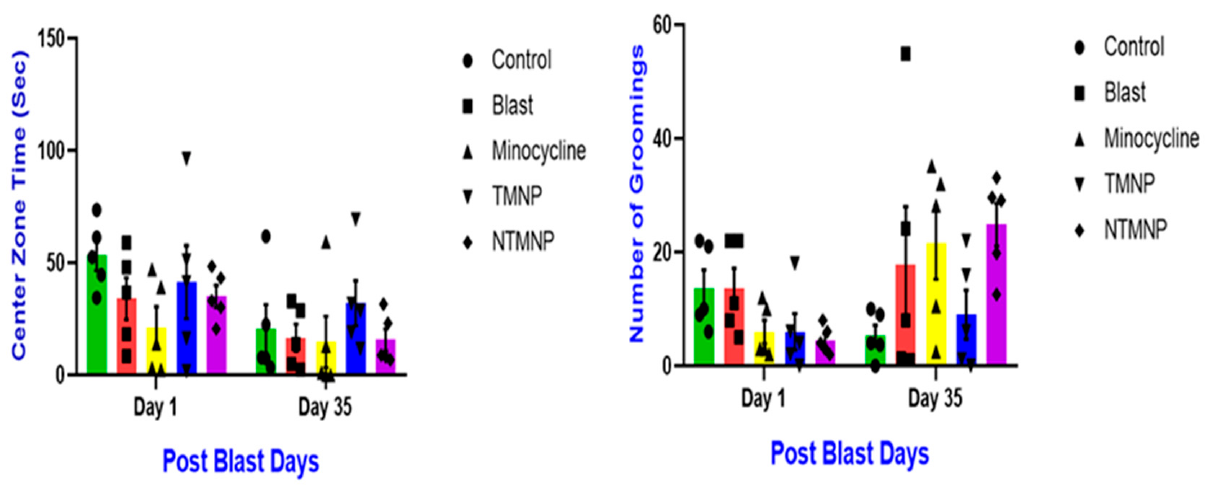
Figure 11. Free minocycline, targeted (TMNP), and non-targeted minocycline (NTMNP) nanoparticles reduced moderate blast-induced gross motor skills and anxiety.